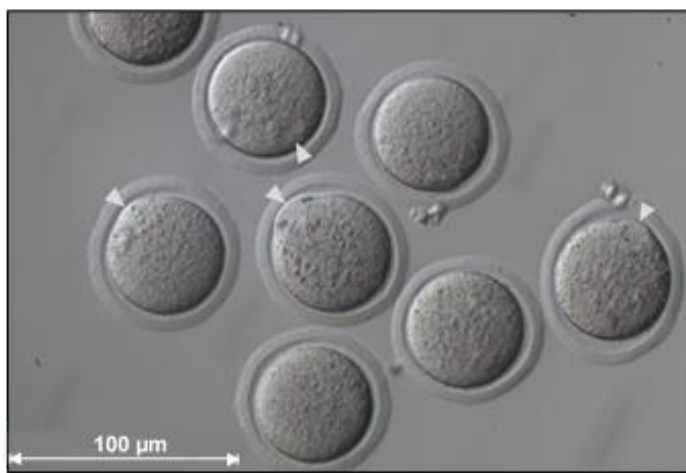
Figure 3. Photo image of B6D2F1 mouse oocytes. Meiotic spindle complexes (visible as a translucent region with an occasional bulge) are indicated by white arrowheads (image captured by C.G. as part of her Masters dissertation at the Reproductive Biology Laboratory, University of Pretoria).